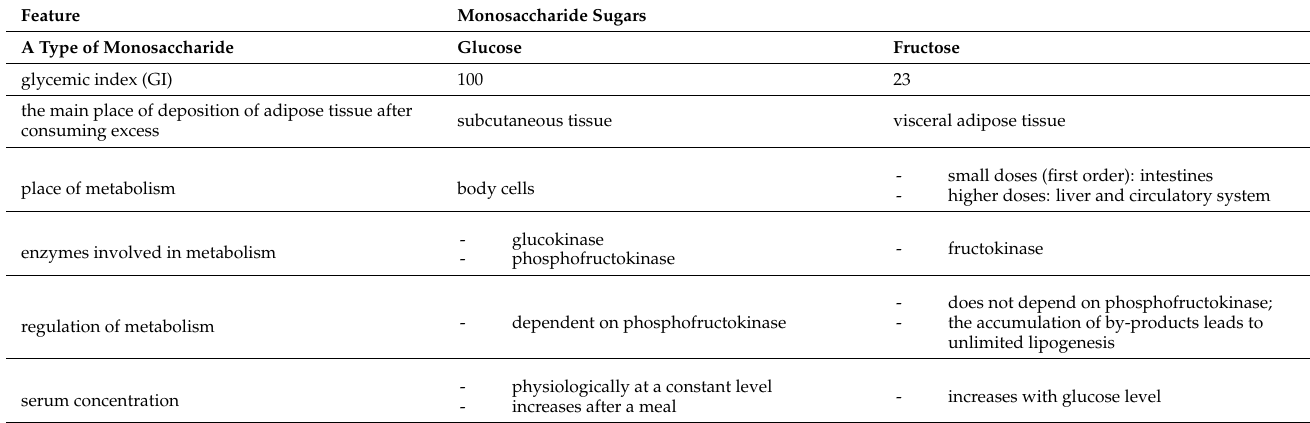
Table 2. Comparison of glucose and fructose metabolism